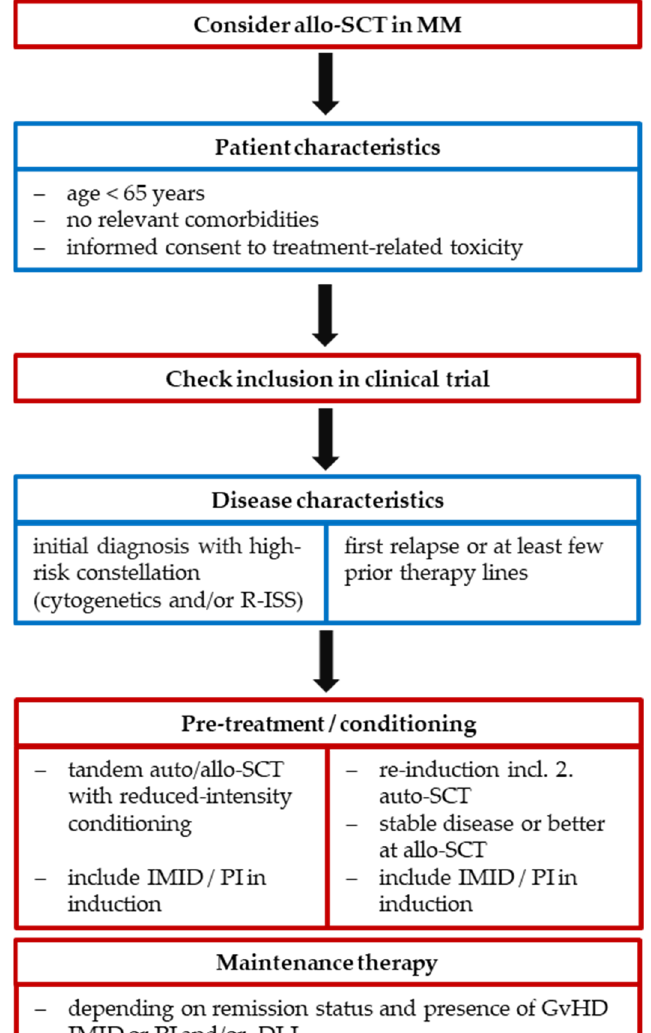
Figure 1. Consideration criteria for allo-SCT in MM. Abbreviations: R-ISS = revised international staging system; auto/allo-SCT = autologous/allogeneic hematopoietic stem cell transplantation; MM = multiple myeloma; DLI = donor lymphocyte infusions; IMID = immunomodulatory drugs; PI = proteasome inhibitors; GvHD = graft-versus-host disease.